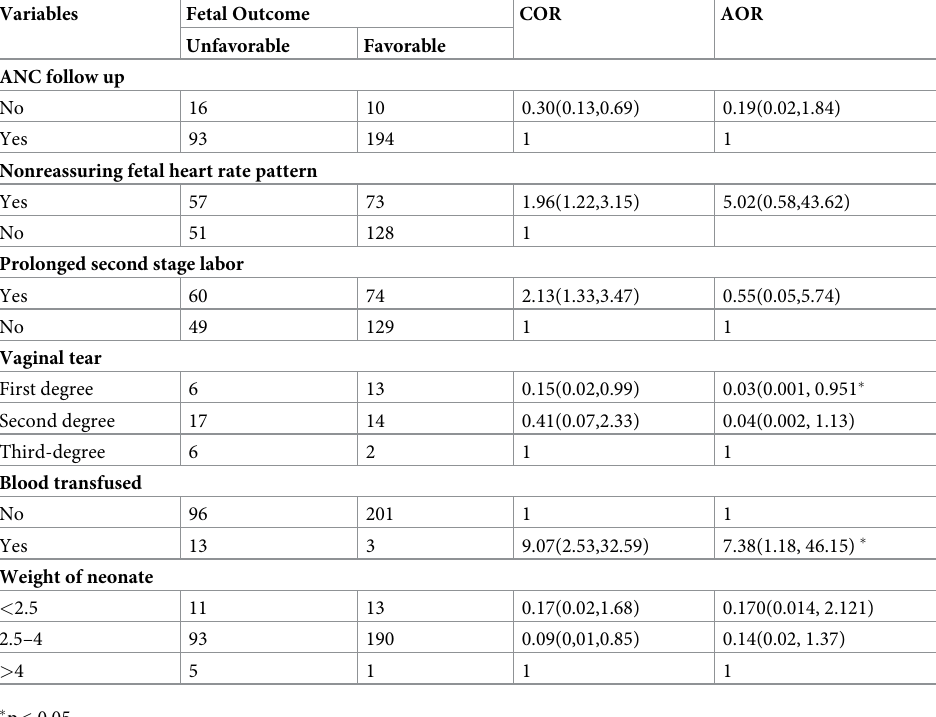
Table 4. Factors associated with fetal outcomes of OVD in East Gojjam Zone Hospitals, Northwest